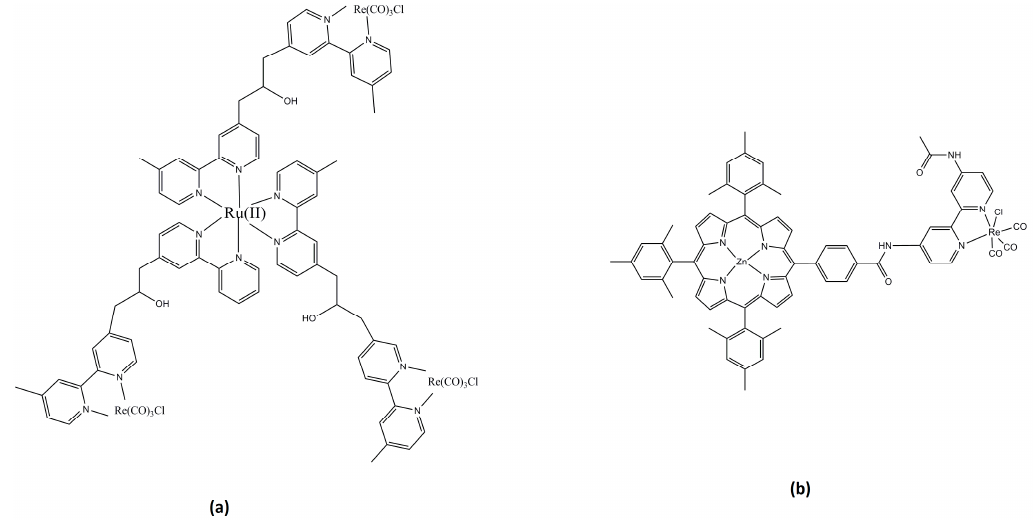
Figure 24. An example of ( a ) trinuclear complex of Re(I) ‐ Ru(II); and ( b ) binuclear Zn(II) ‐ Re(I) complex with porphyrin ligand utilized as molecular photocatalysts for the photoactivation of CO 2 reduction ([169,183] and references therein).